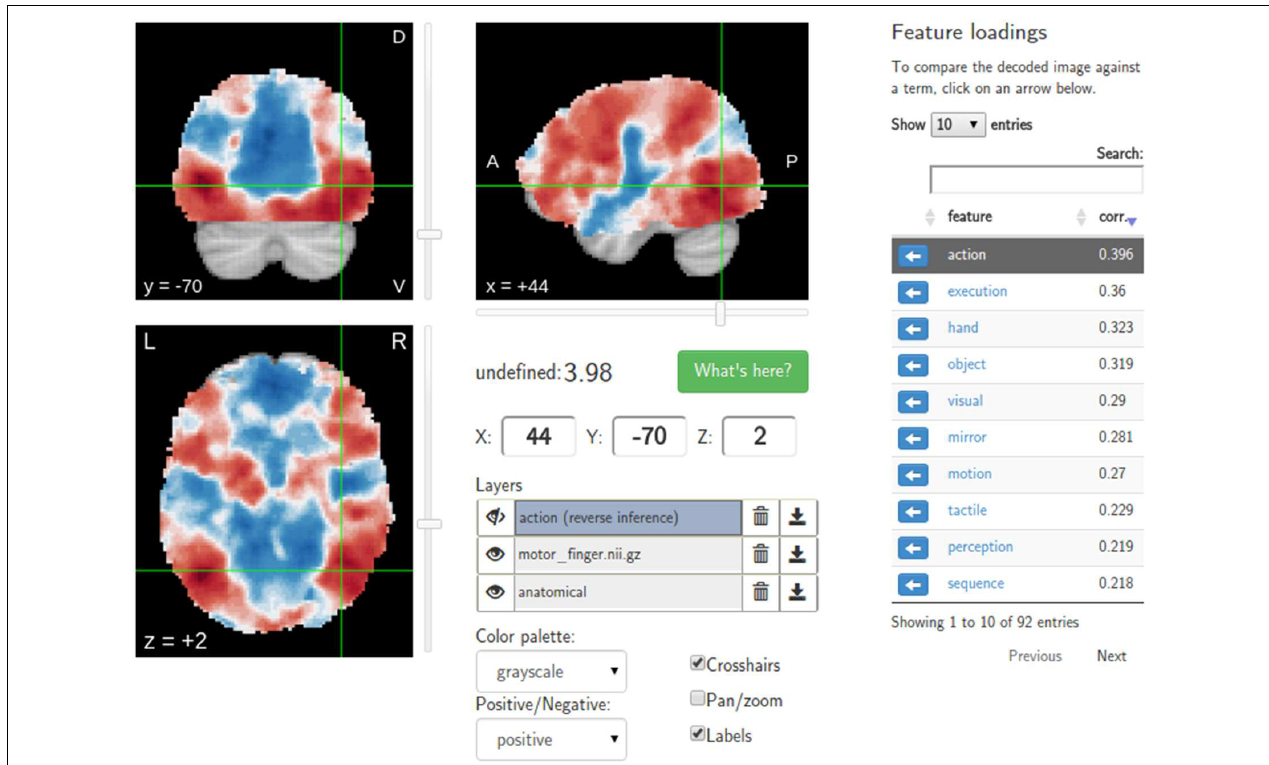
FIGURE 3 | Results of the Neurosynth decoding of a statistical map obtained through NeuroVault API. Users are able to interactively compare their maps with Neurosynth topic maps.